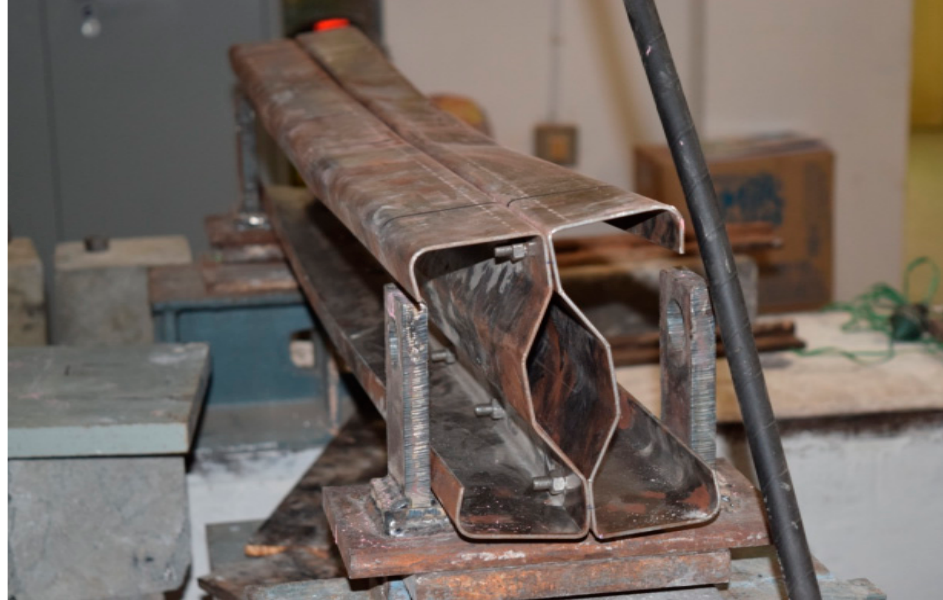
Figure 11. The failure mode of B2B157.